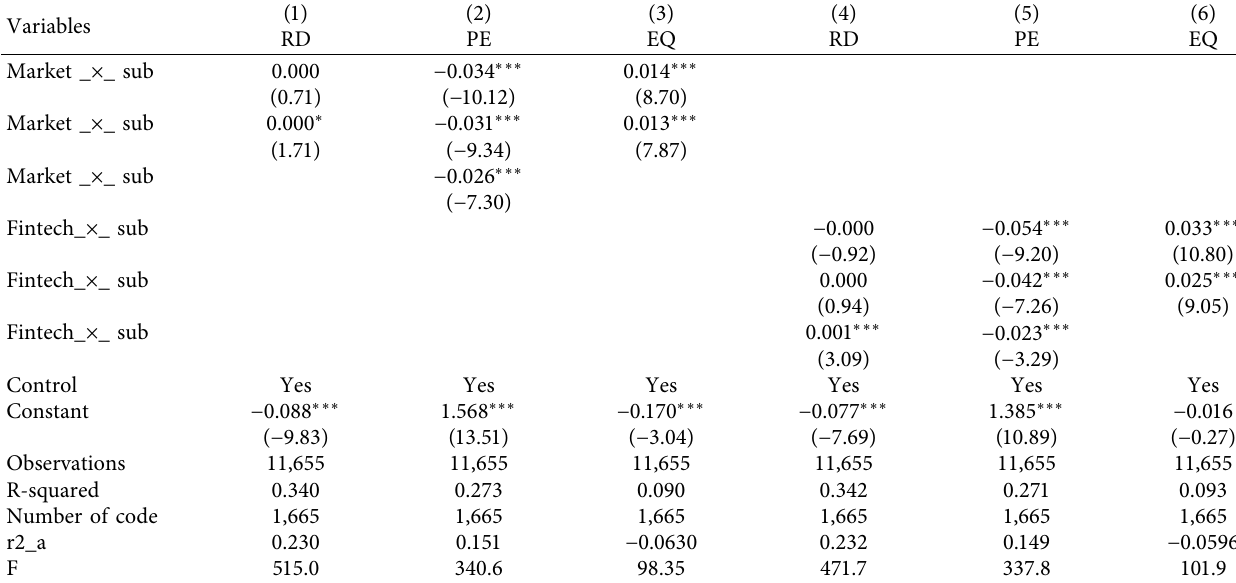
Table 9: Threshold effect regression results.